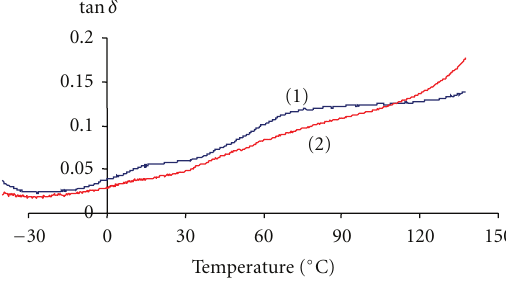
Figure 9: Damping variation of unfilled (1) and mica-filled (2) pol- ypropylene. Table 1: Δ α and f g for transition α and transition αc zones. Transitions